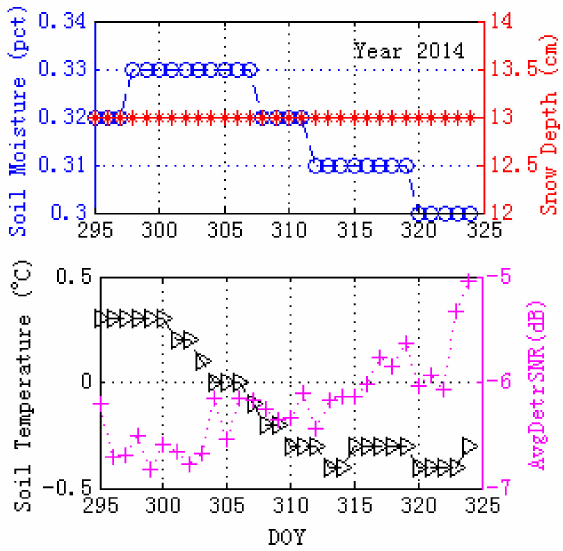
Figure 11. Comparison between GPS site (AB33) and SNOTEL site (ID 958) from DOY 295 (2014) to DOY 325 (2014). The elevation angle is 20 ◦ . The upper panel presents the comparisons of soil moisture (blue O) and snow depths (red *). Comparisons of soil temperature (black (cid:52) ) and ADSNR (pink +) are presented in the bottom